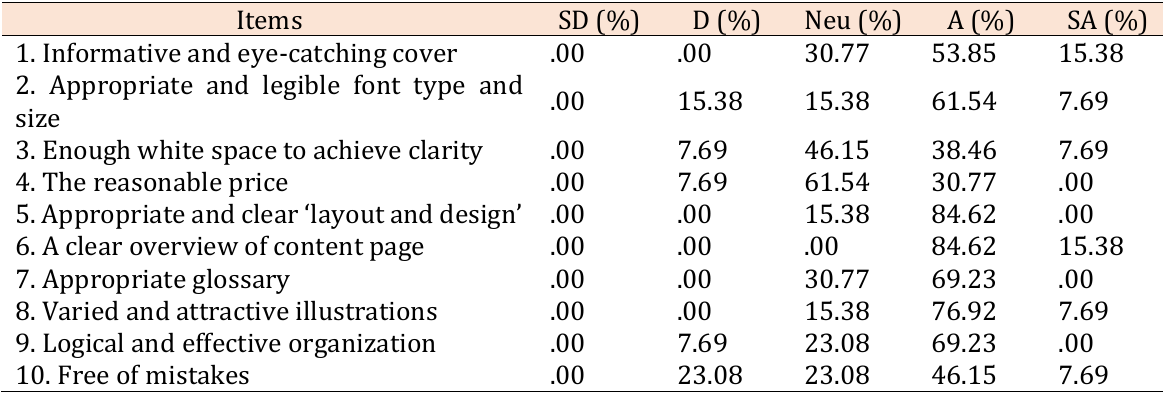
Table 3. EFL teachers’ evaluation of physical and utilitarian